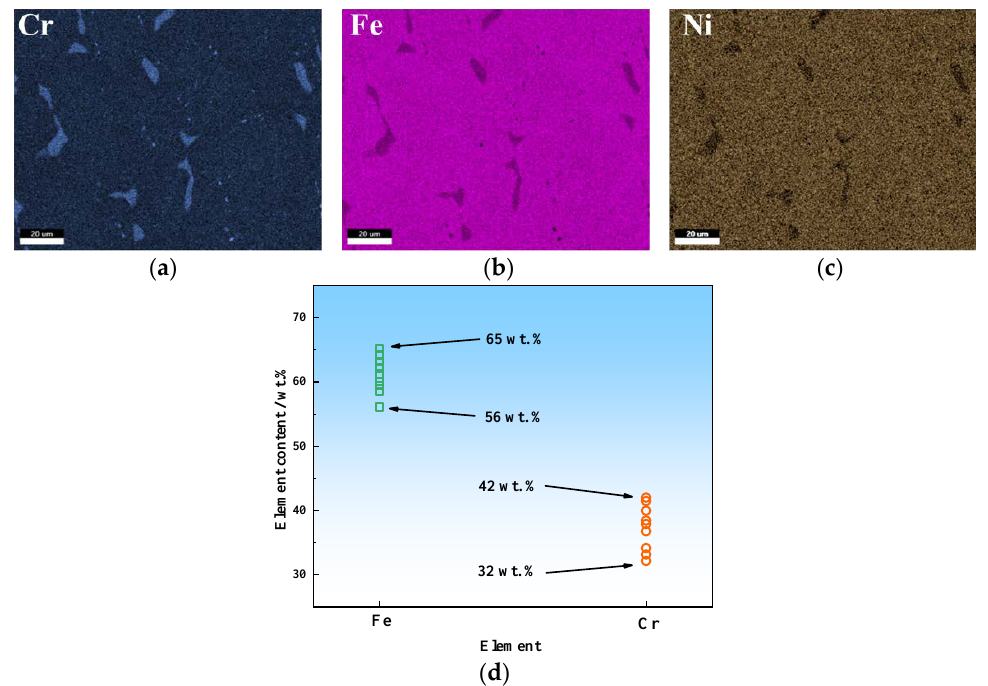
Figure 3. Scanning electron microscopy (SEM) images of the 304H stainless steel showing the variation in the proportion of Cr and Fe in the sigma phase in the nine Fe-Cr precipitates examined. ( a ) is distribution of Cr element in austenite and σ -phase, ( b ) is distribution of Fe element in austenite and σ -phase, ( c ) is distribution of Ni element in austenite and σ -phase and ( d ) is the change in Cr and Fe in the nine σ -phases (the green icon shows the change in the content of Fe element in different σ -phases and the orange icon shows the change in the content of Cr element in different σ -phases).